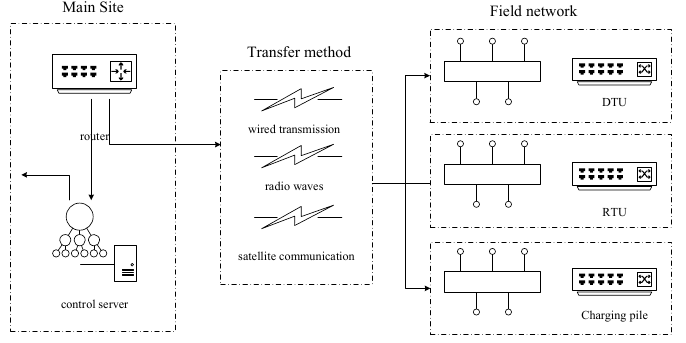
Figure 2. Electricity IoT architecture diagram.